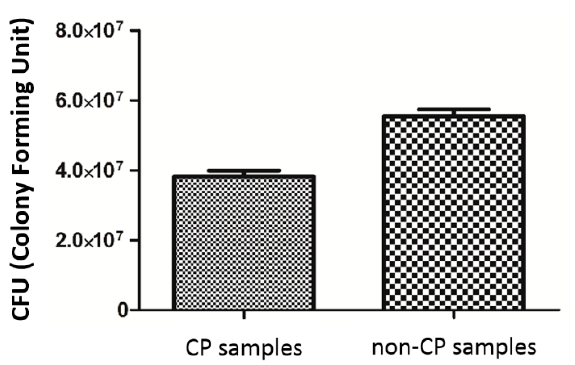
Figure 13. S. epidermidis biofilm formation on non-CP and CP samples.